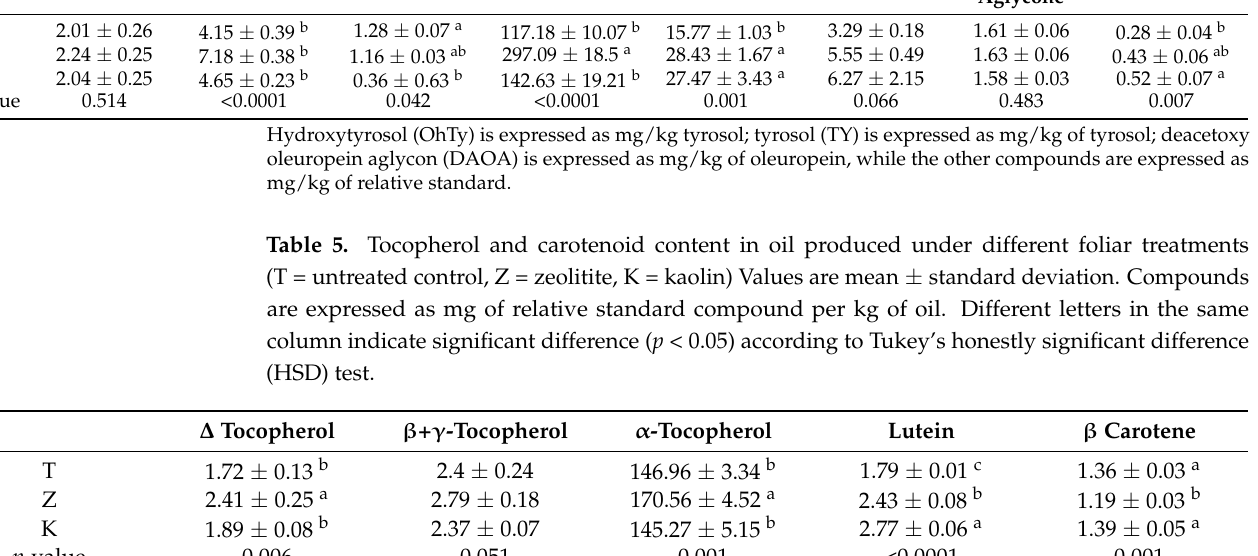
Table 4. Phenolic profile determined in oils produced by plants treated with different foliar treatments (T = untreated control, Z = zeolitite, K = kaolin). Different letters in the same column indicate significant difference ( p < 0.05) according to Tukey’s honestly significant difference (HSD) test. Luteolin Luteolin Aglycone